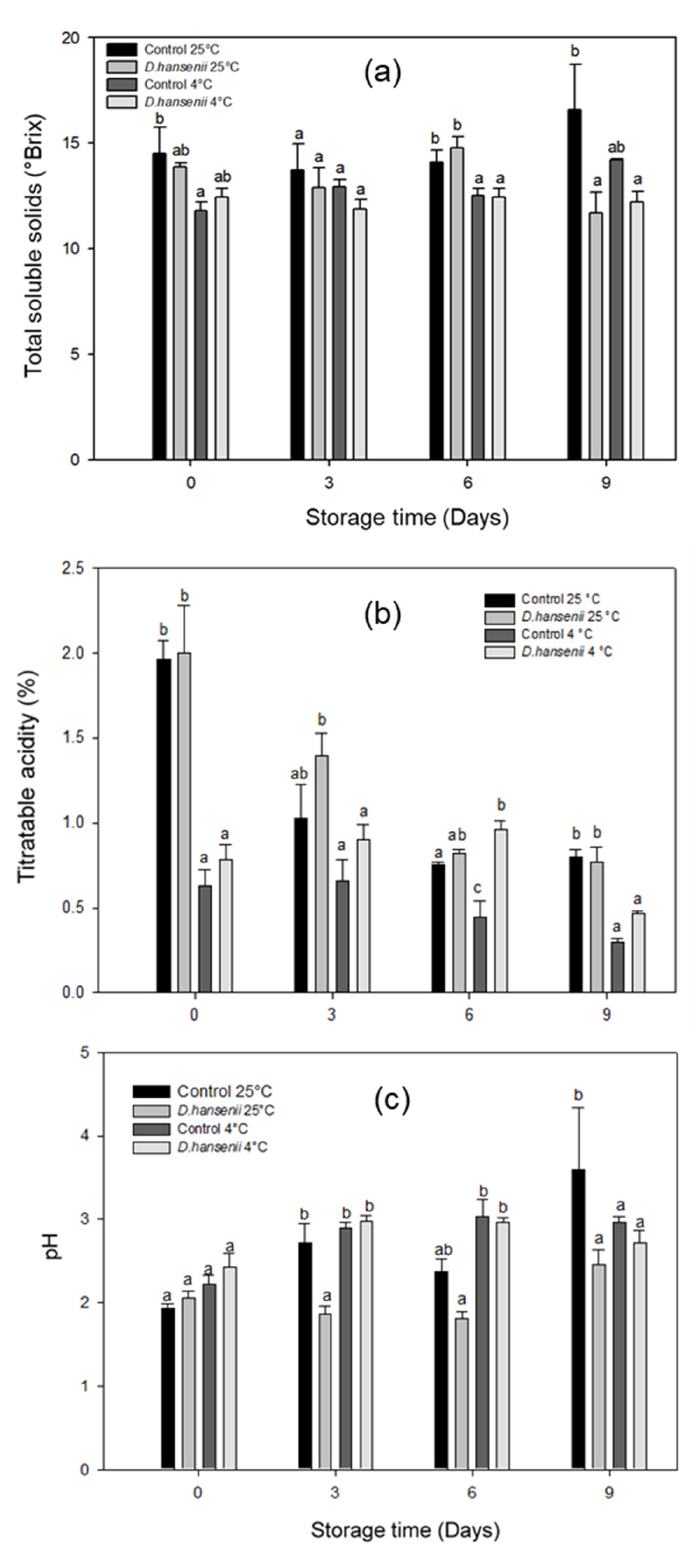
Figure 5. Total soluble solids ( a ), pH ( c ), and titratable acidity ( b ) of blueberries stored at 25 °C and 4 °C under the application of D. hansenii . Values are expressed as mean ± standard error. Different letters in the bars indicate significant differences between treatments at ( p <